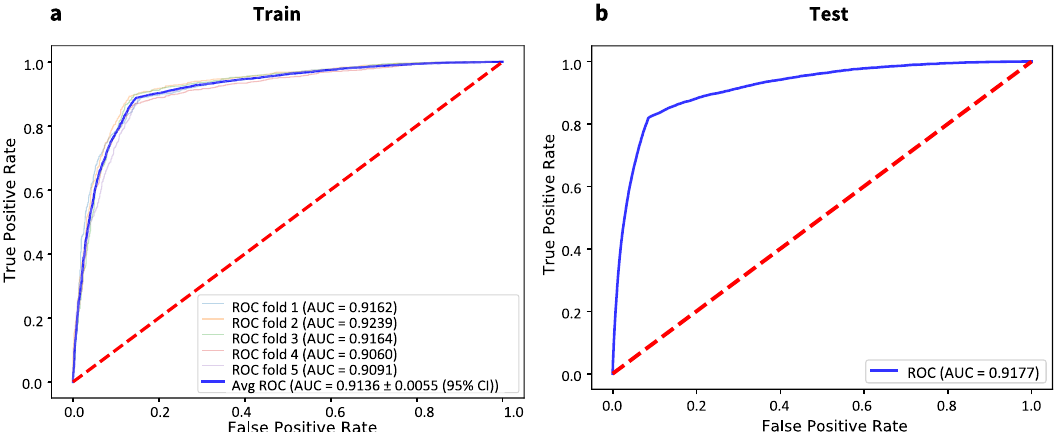
Fig. 4 AUROC values for the proposed stacking model. a Cross-validation performance. b Test set performance. N = 91,014 train CBCs and 261,630 test